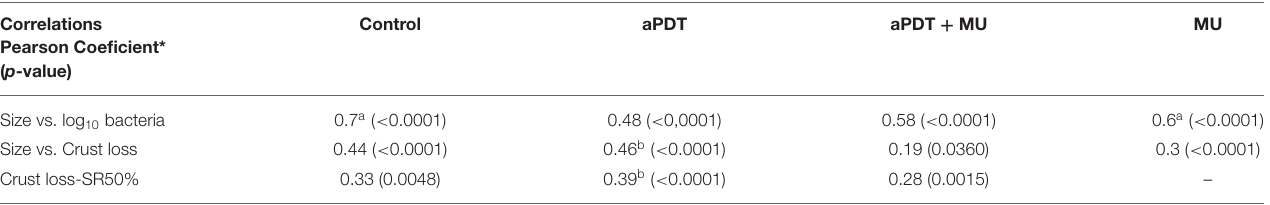
TABLE 3 | Significant correlations (Pearson coefficient) and p -values and in numerical parameters for wounds in model assay (control) and wounds on therapy. Correlations Pearson Coeficient*